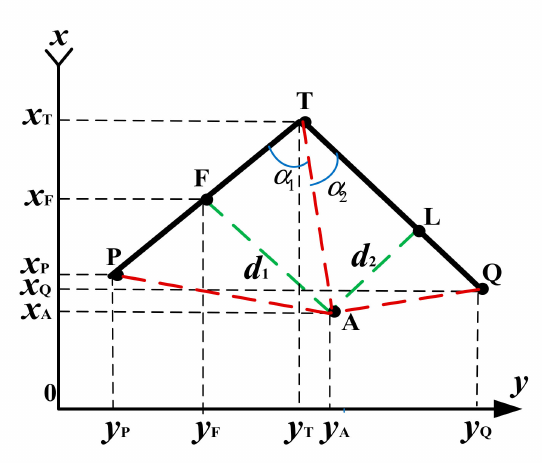
Figure 5. Upward-convex option of flood zone